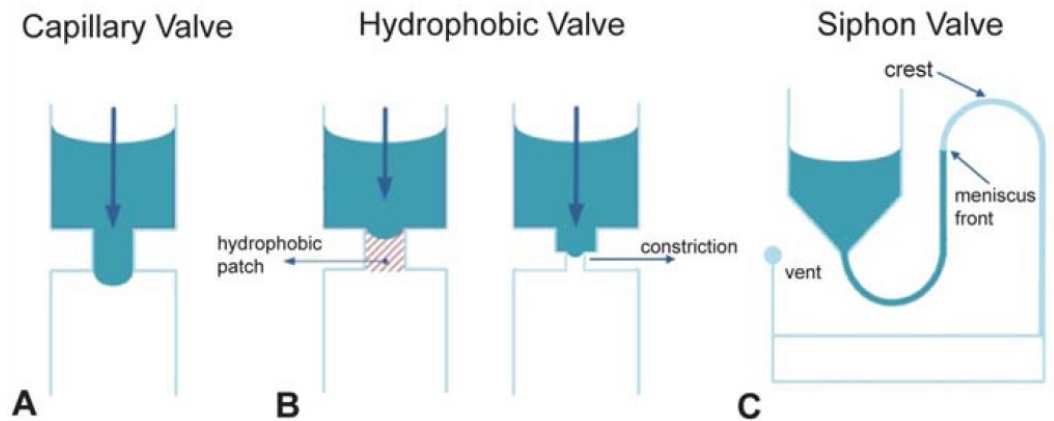
Figure 4. Examples of commonly-used valving techniques in centrifugal microfluidic